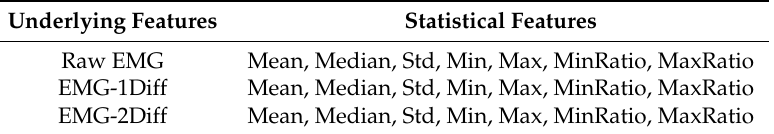
Table 3. Features extracted from EMG signal.